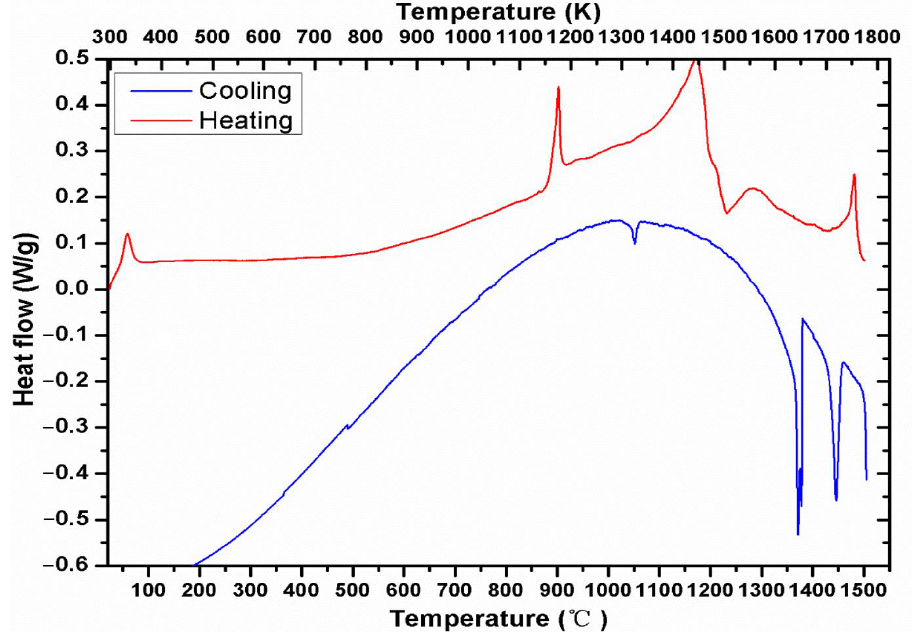
Figure 11. High temperature DSC testing result of as-built Ti-Ni-Hf-Cu-Nb2.5 high M s sample indicates multi-phases and changes of local composition in some phases.